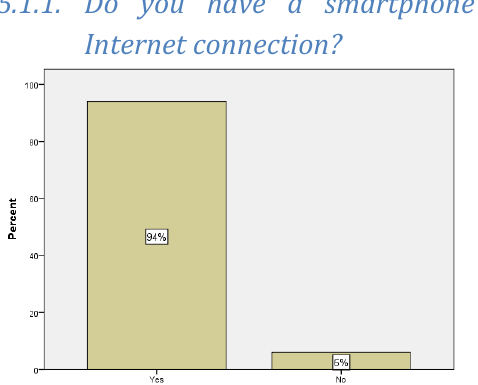
Figure 2: Bar chart showing percentage of respondent’s with a smartphone